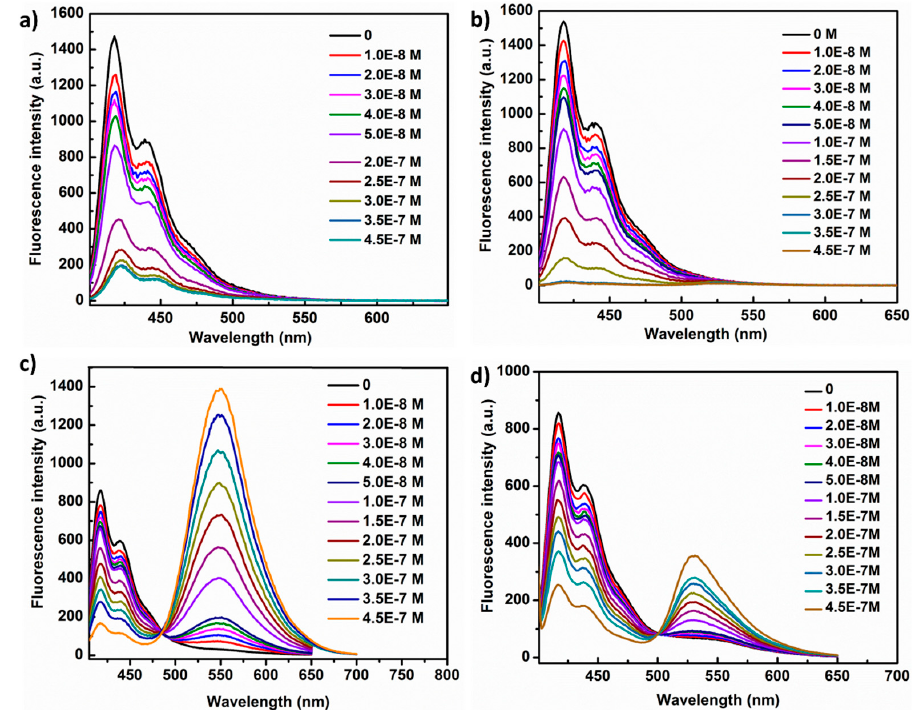
Figure 5. PL spectra of PFC3N after addition of ssDNA ( a ) and ssDNA-FAM ( b ) at adverse concentrations; PL spectra of PFC3NBT after addition of ssDNA ( c ) and ssDNA-FAM ( d ) at adverse concentrations ((RU) of CPEs = 6 μ M, excitation at 380 nm).